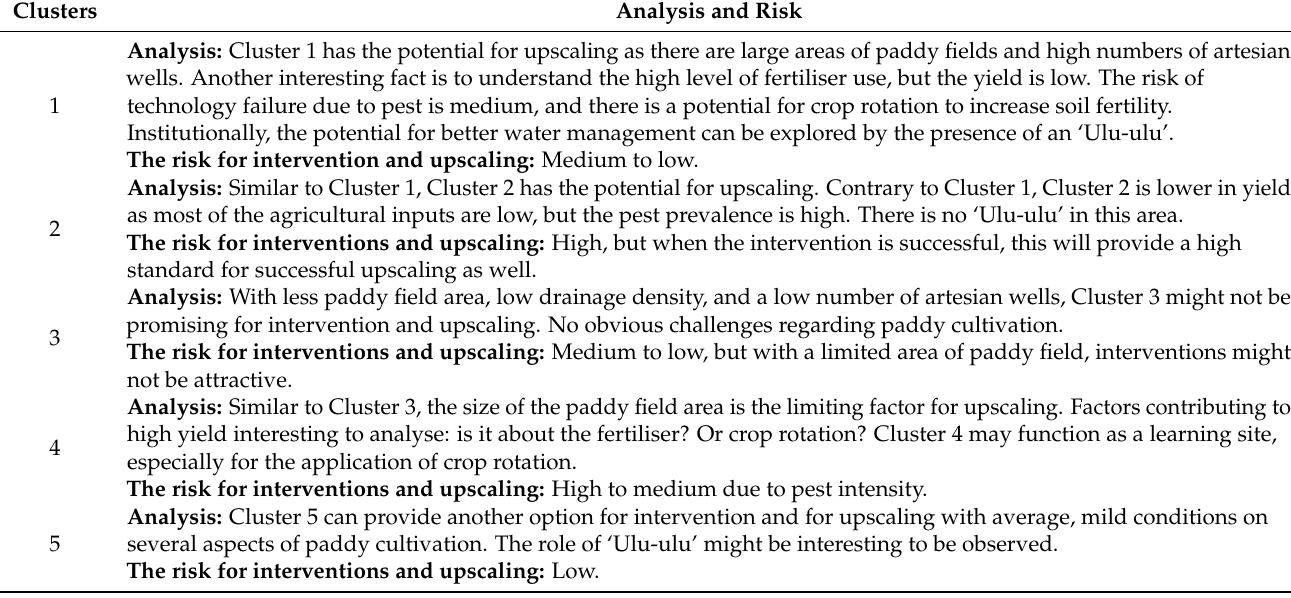
Table 8. Analysis and risk for intervention and upscaling of each paddy field cluster, based on feedback in local focus group